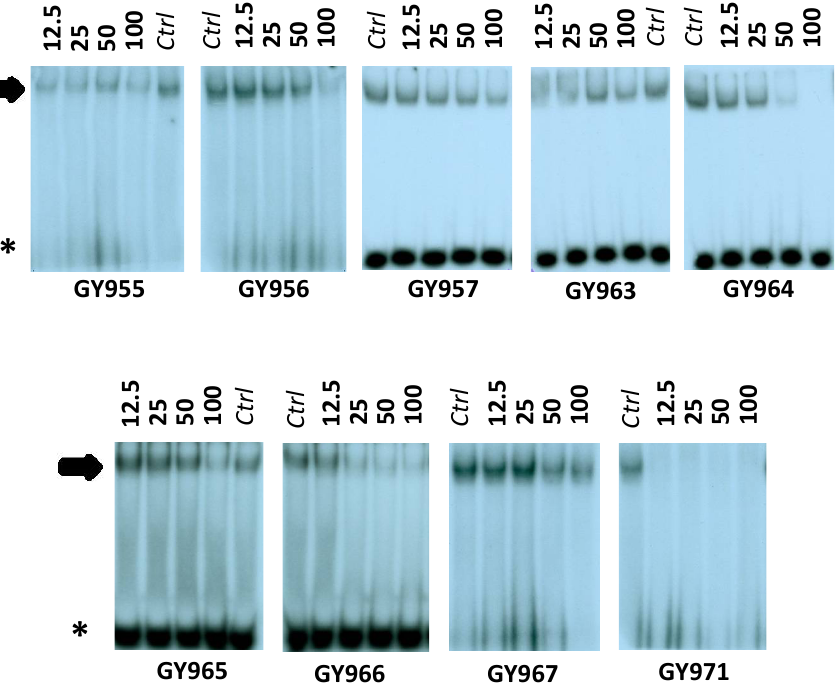
Figure 3. Effects of TMA analogues at 12.5–100 µ M concentrations in EMSA experiments on the molecular interactions between NF- κ B p50 and 32 P-labeled target NF- κ B double-stranded oligonucleotide. The arrow indicates NF- κ B/DNA complexes; the asterisk indicates the free 32 P-labeled target NF- κ B probe. Table 1. MIC values for the TMA analogues in EMSA experiments.